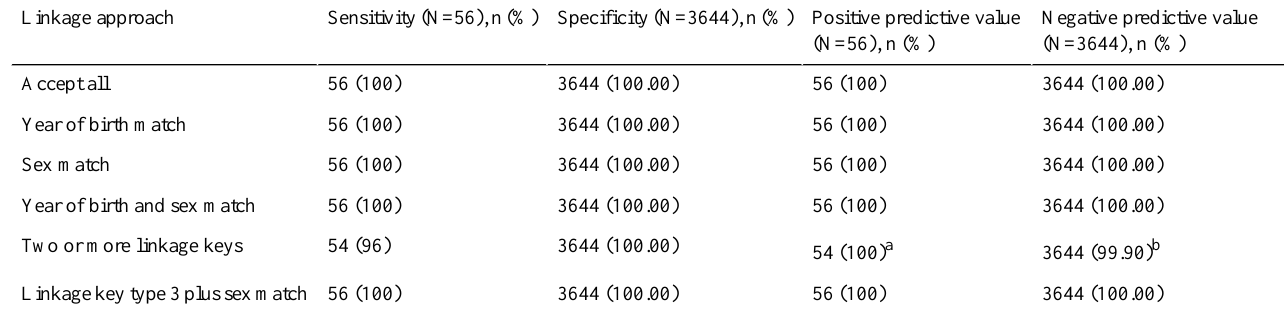
Table 3. Evaluation measures derived from using the GRHANITE Linkage Tool on the PrEPX gold-standard dataset.